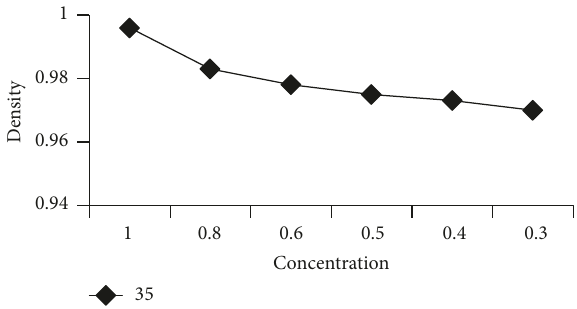
Figure 1: Variation of density with concentration at 35 ∘ C temperature.